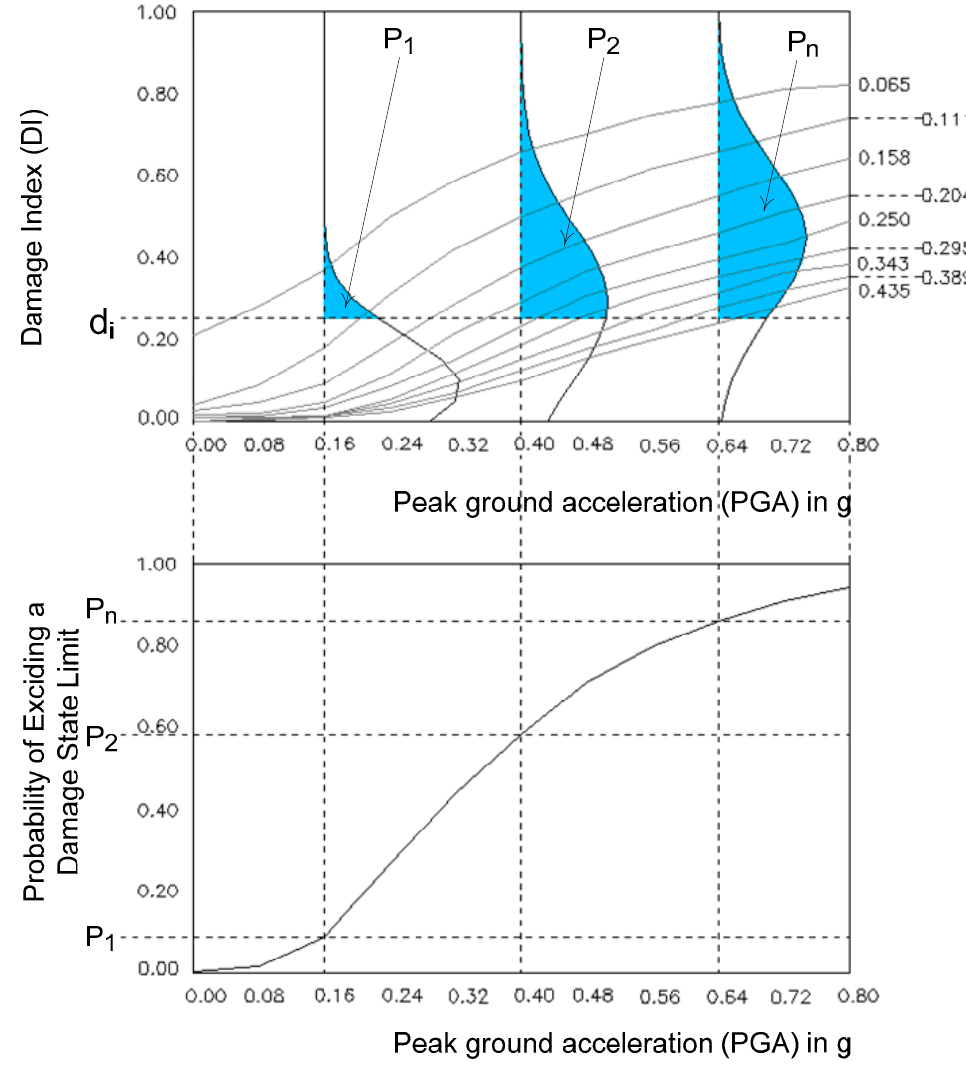
Figure 15. Development process of analytical fragility curves.